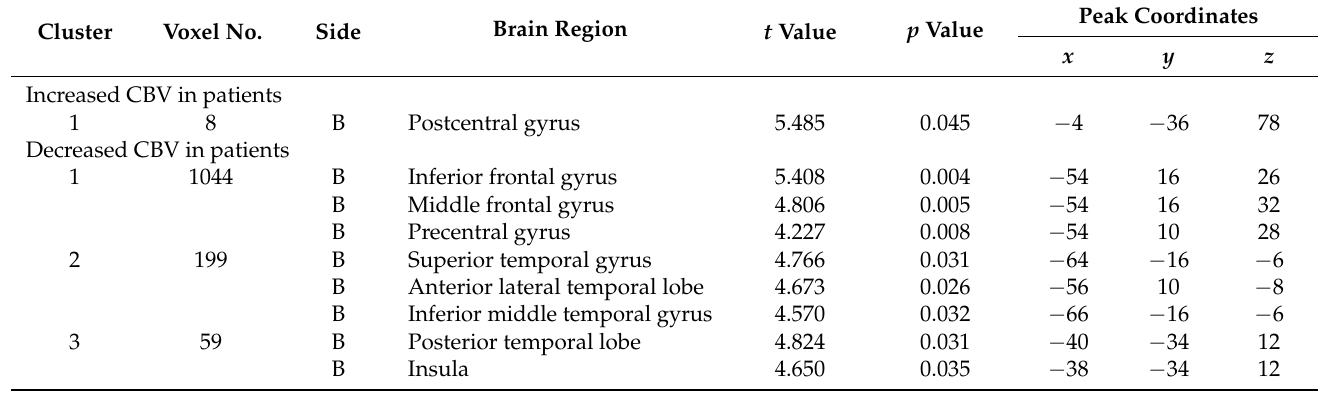
Table 2. Clusters of increased or decreased CBV in all burn patients relative to controls.